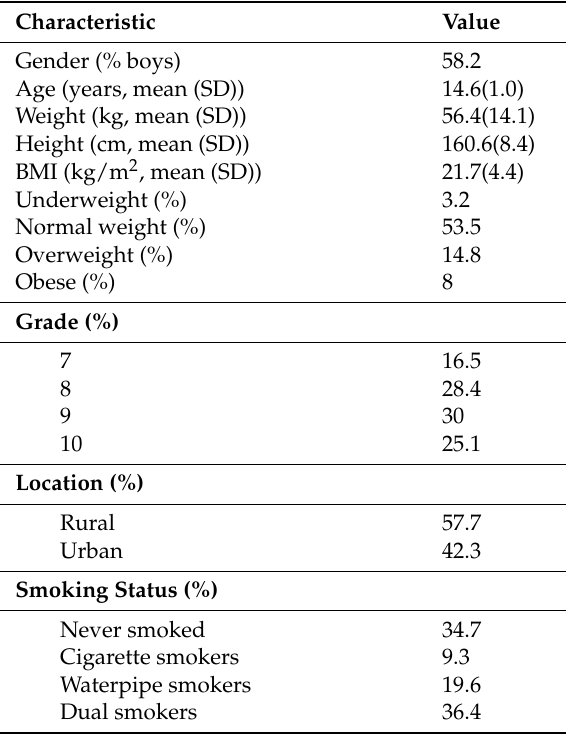
Table 1. The participants’ demographic characteristics ( n =